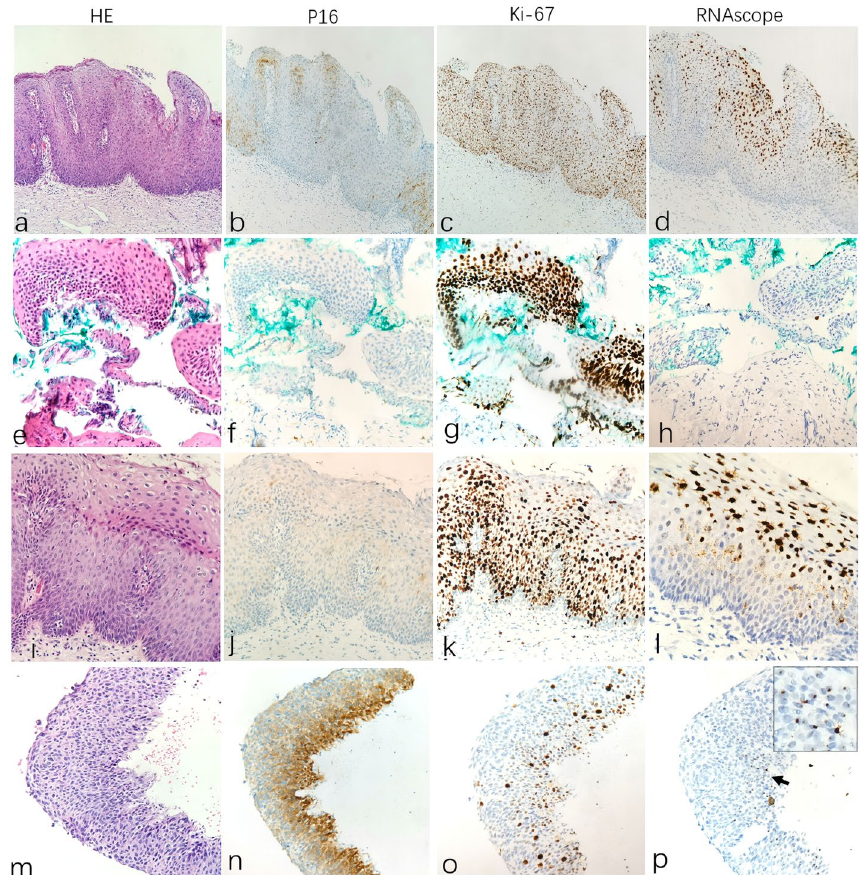
Fig. 2 The H&E morphology, P16/Ki67 phenotype and RNAscope expression patterns in Test-A group. Row1 ( a - d ): In P16- CIN1 case, RNAscope show diffuse clustered expression pattern in nuclei/cytoplasmic, staining areas is mainly located on the surface epithelium ( d ). Row2 ( e – h ): P16- CIN1 cases but RNAscope is negative ( h ). Row3 ( i - l ): In P16- CIN2 case, RNAscope show diffuse cluster positivity and cytoplasmic punctate positivity in superficial cells and scattered punctate positivity in basal and parabasal nuclei/cytoplasmic ( l ). Row4 ( m - p ): In P16- CIN3 case, RNAscope show dotted full-thickness nucleus/cytoplasmic scattered staining ( p ,